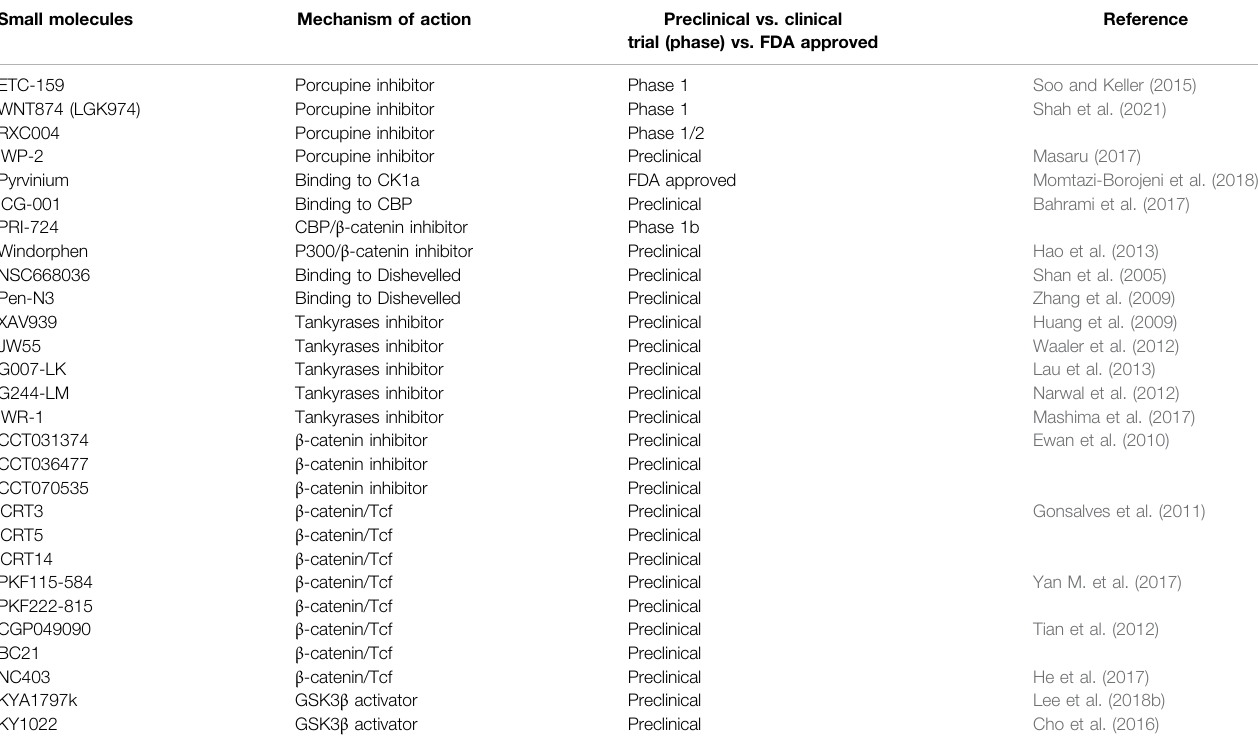
TABLE 1 | List of small molecules targeting Wnt/ β -catenin pathway for CRC treatment. Small